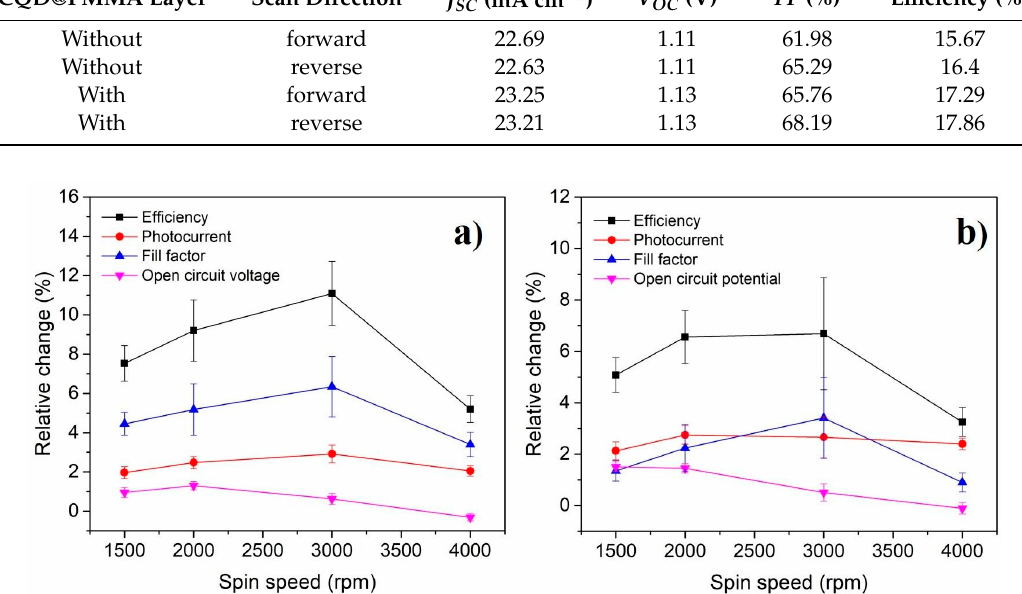
Figure 5. Dependence of relative change in the photovoltaic parameters on the spinning speed used to deposit a CQD@PMMA coating on PSCs. Key photovoltaic parameters extracted from J–V curves measured in ( a ) forward and ( b ) reverse scan directions.